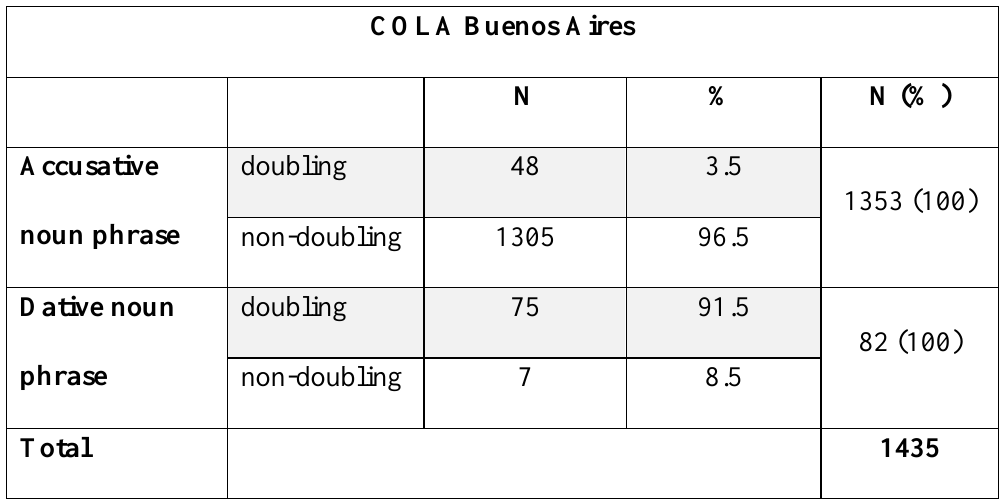
Table 3. Proportion of doubling of accusative and dative noun phrases in COLA Buenos Aires (Rinke et al. 2019: